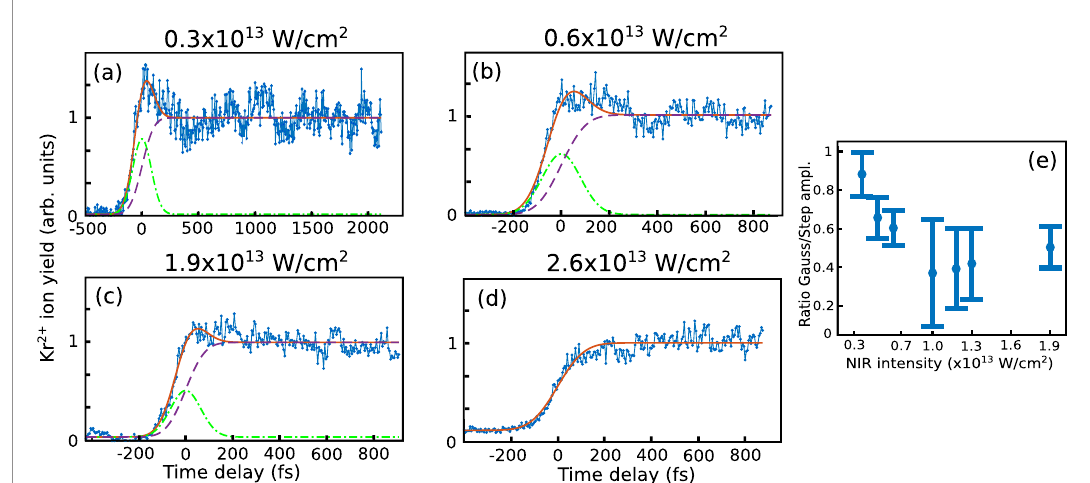
Figure 3. Kr 2 + ion yields as a function of XUV-pump and NIR-probe delay, obtained with HH21 at four different NIR intensities (a)–(d). Measured ion yields (blue line and dots) are fitted with a sum of a smoothed step (purple dashed line) and a Gaussian (green dashed line) functions. The combined fits of the ion yields are plotted as red solid lines. (e) Shows the ratio between the Gaussian and smoothed step function maximum amplitudes versus of the NIR intensity. Error bars show the 95 % confidence bound obtained from the fits. Note the longer time scale in (a).